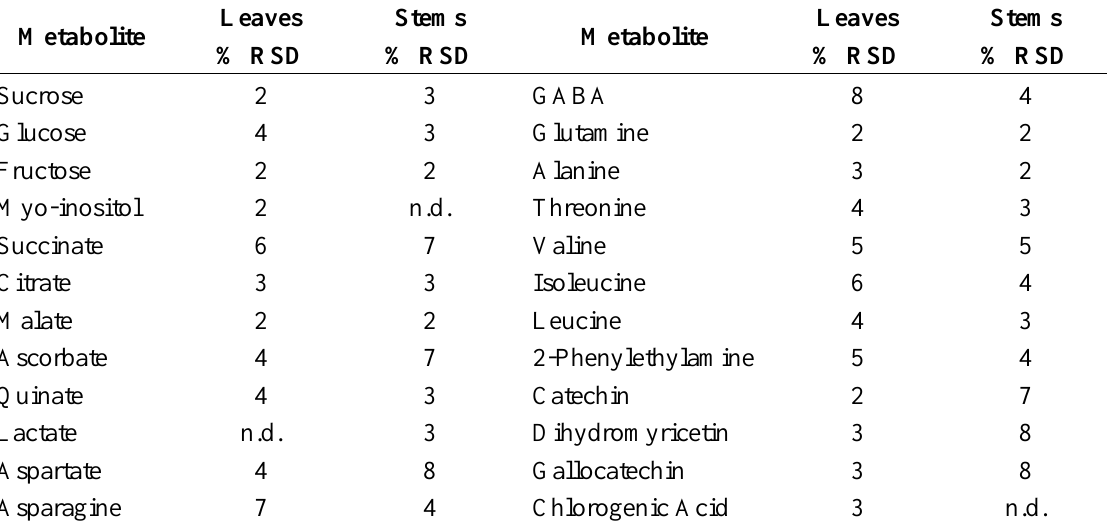
Table 3. Relative standard deviations (RSD) observed for characteristic metabolite regions in leaf and stem 1D 1 H-NMR data. Data is based on three technical replicates per biological sample. Reported values represent the average % RSD observed across all leaf or stem samples. n.d. denotes a metabolite that was not quantified in a particular